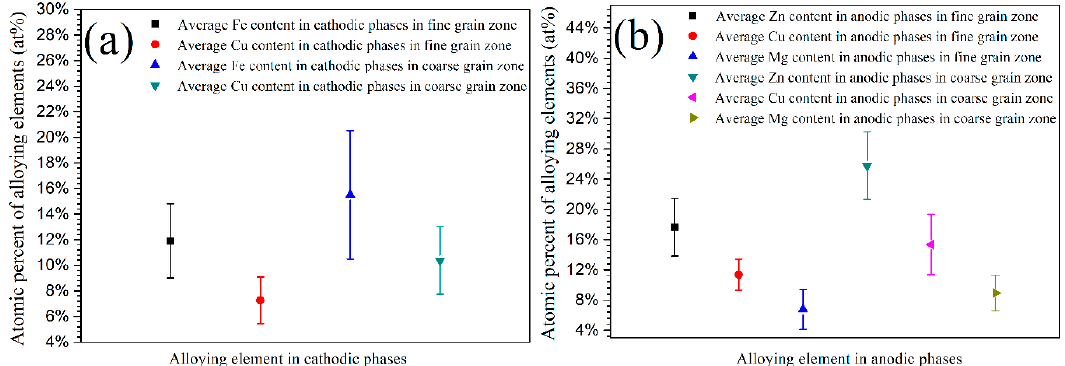
Figure 5. Average atomic percent of alloying elements in intermetallic phases in coarse and fine grain zones, ( a ) in cathodic phases and ( b ) in anodic phases.